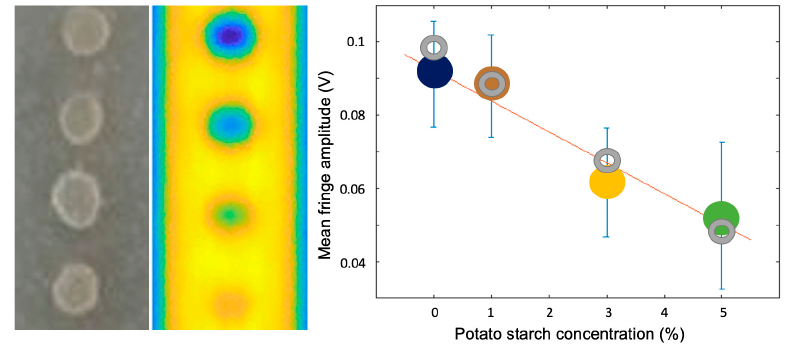
Figure 8. From left to right: photography and full-system simulated image of potato starch pills dispersed in PDMS matrix. Rightmost: measured (color bullets) and calculated (grey rings) fringe amplitude versus starch concentration averaged across the pills surface (adapted from Reference [41]).